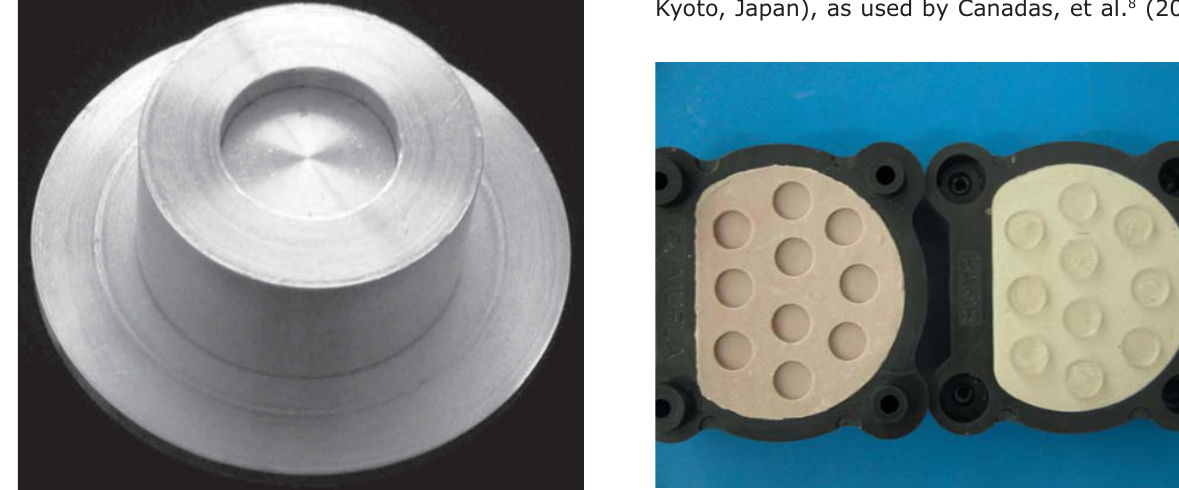
Figure 1- Metallic matrix with 15-mm diameter and 2-mm thickness